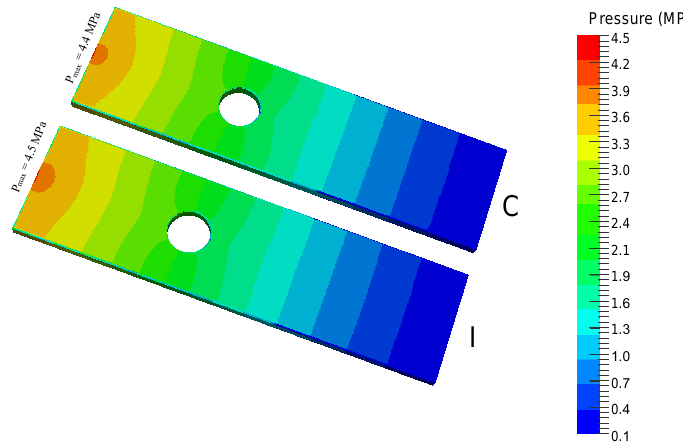
Figure 7. Distribution of the pressure field on the mold cavity, for the two formulations, compressible (C) and incompressible (I), at the switch-over